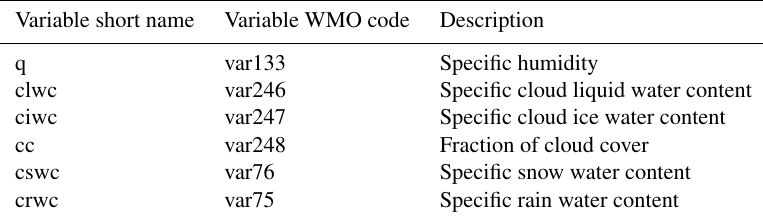
Table A3. Model-level variables on a Gaussian reduced grid in the ICMGGoifsINIUA